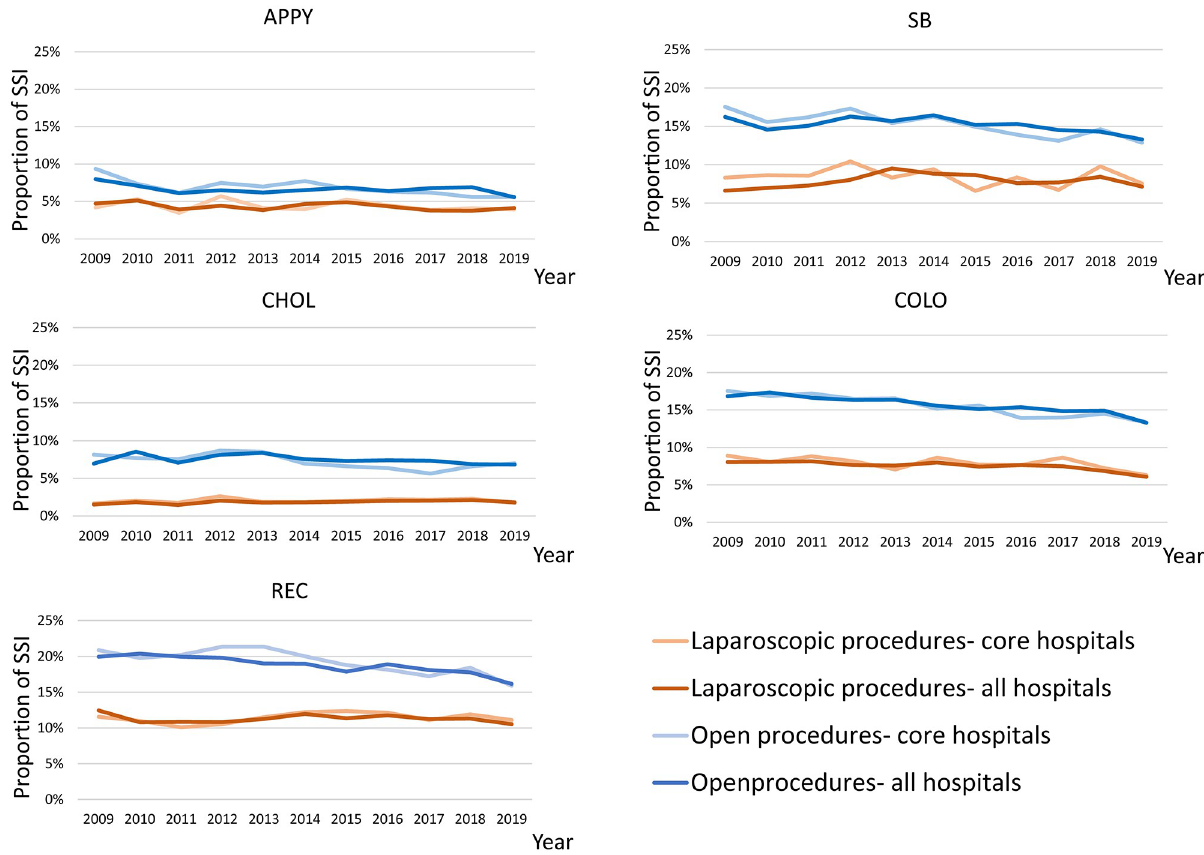
Fig 3. Proportion of surgical site infection for each of the five digestive surgeries stratified by laparoscopic and other procedures, as well as the core and all hospitals. The blue line shows the surgical site infection rate for open procedures in all participating hospitals. The light blue line shows the surgical site infection rate for open procedures in the core participating hospitals. The orange line shows the surgical site infection rate for laparoscopic procedures in all participating hospitals. The light orange line shows the surgical site infection rate for laparoscopic procedures in the core participating hospitals.